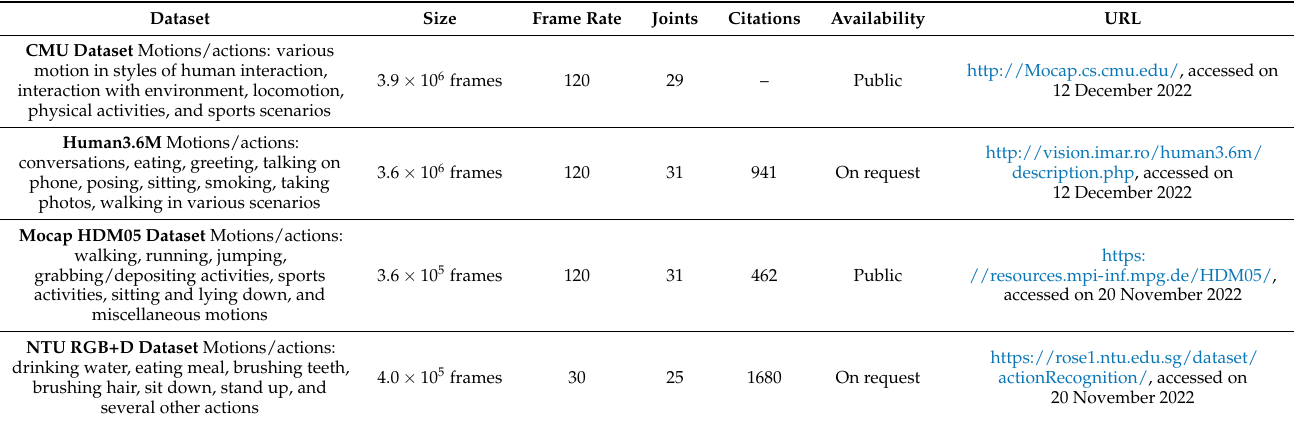
Table 2. Summary of motion